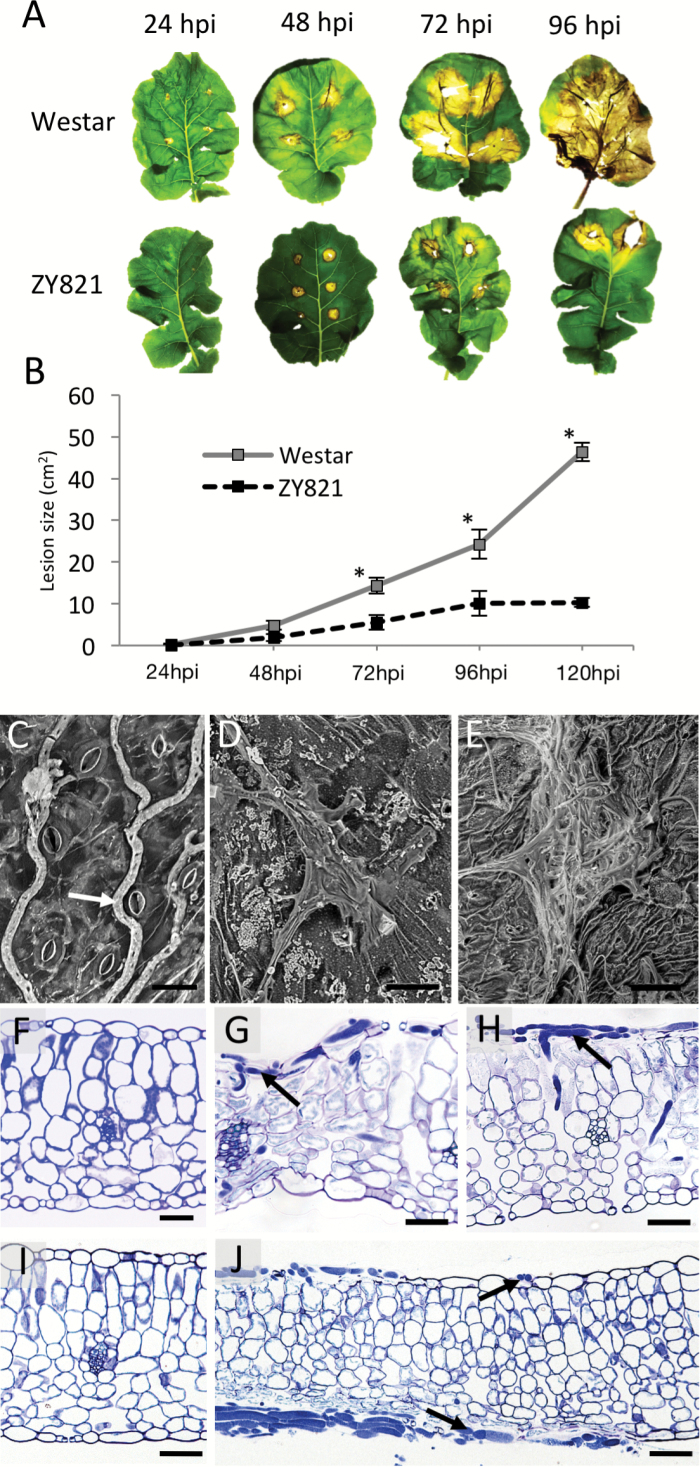
Characterization of the Brassica napus-Sclerotinia sclerotiorum pathosystem. (A) S. sclerotiorum lesion progression in B. napus susceptible (cv. Westar) and tolerant (cv. ZY821) genotypes. (B) Lesion size measurements±standard deviation from 24–120 hours post-inoculation (hpi) in Westar and ZY821, * indicates ANOVA P-value<0.05. (C) Scanning electron micrograph of S. sclerotiorum hyphae (arrow) avoiding stomata on the adaxial epidermis of Westar 24hpi. Representative S. sclerotiorum infection cushions on abaxial epidermis of (D) Westar and (E) ZY821. (F-J) Light microscopy of transverse leaf sections stained with Toluidine Blue O. (F) Un-inoculated section of healthy Westar tissue. (G) Westar leaf 48hpi showing extensive membrane shrinkage caused by S. sclerotiorum, and darkly staining hyphae (arrow). (H) Infection cushion (arrow) on adaxial epidermis of Westar 48hpi. (I) Un-inoculated healthy section of ZY821 tissues. (J) Cross-section of infected ZY821 leaves showing limited cellular degradation in advance of S. sclerotiorum hyphae (arrows). Scale bars, C: 80µm; D: 60µm; E: 120µm; F-J: 50µm.